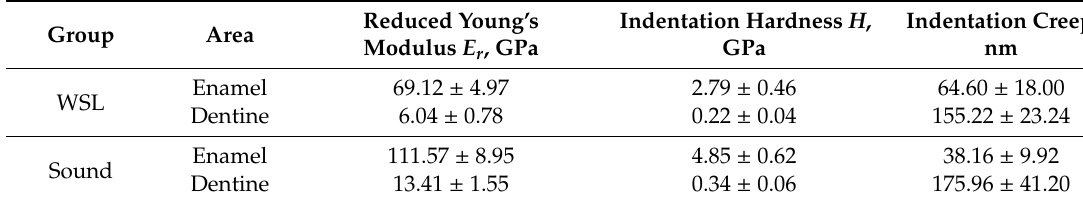
Figure 3. Load-displacement curves for the tooth areas: ( a ) WSL; ( b ) area of sound enamel on the opposite medial side of the tooth; ( c ) dentine bordering the WSL; ( d ) dentine bordering the area of sound enamel. Note the very dissimilar loading and unloading curves for the dentine bordering the WSL in ( c ). Table 2. Mechanical properties of the tooth